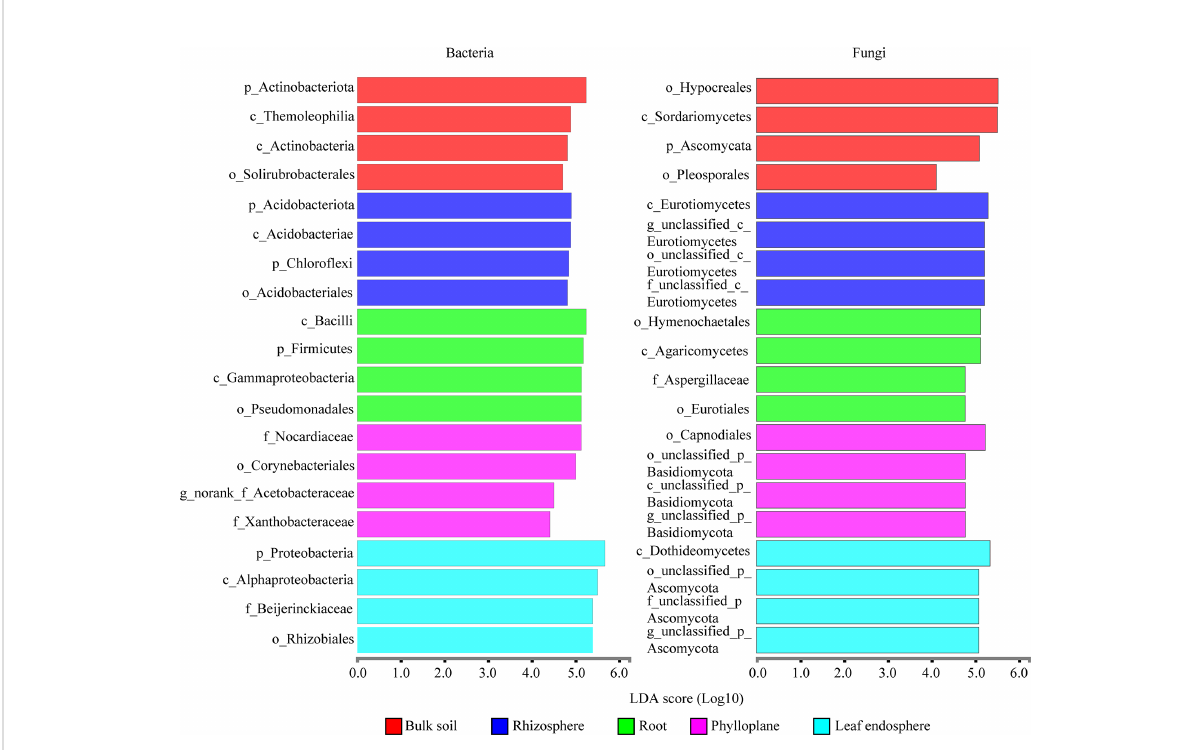
FIGURE 5 Linear discriminant analysis effect size identifying the keystone taxa associated with the different compartment niches (bacteria are on the left; fungi are on the right.). Only the top four most speci fi c biomarker taxonomies are shown.